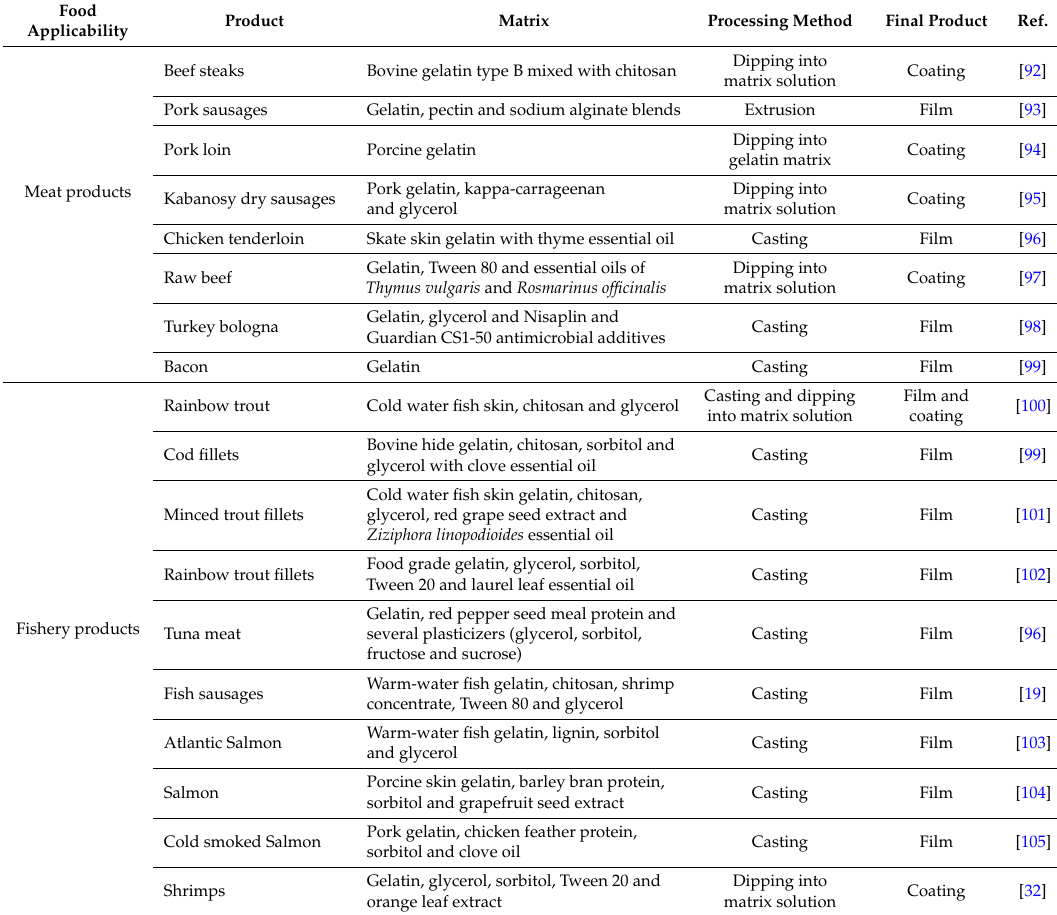
Table 2. Different gelatin matrices used in edible films and coatings for meat and fishery